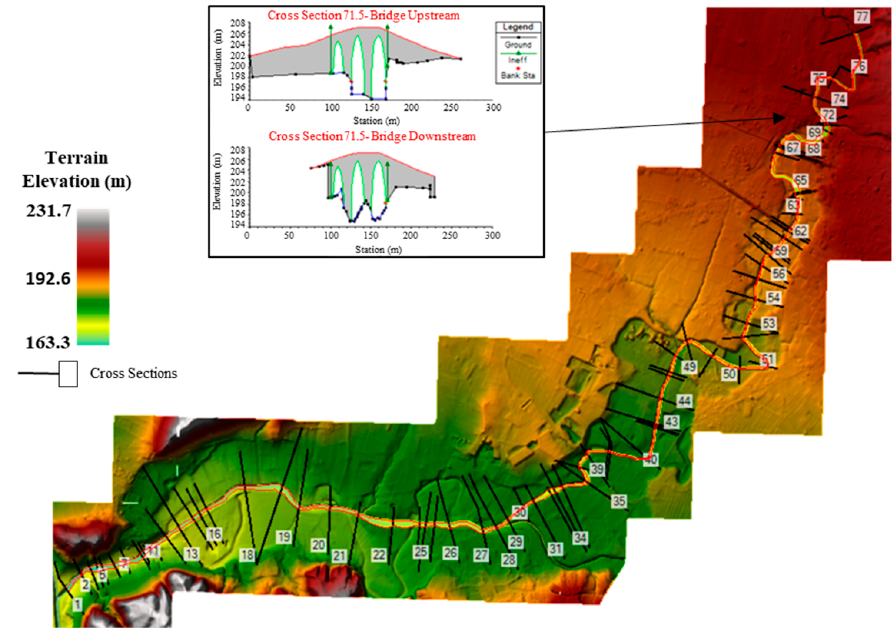
Figure 4. Hydraulic model built with HEC-RAS. The 77 river cross-sections, panel below and a schematized picture of a bridge, panel above.